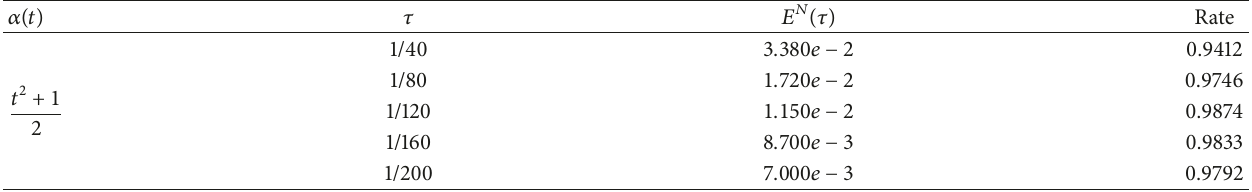
Table 4: Maximum errors and convergence rates for Example 1 at 𝑇 = 1 and 𝜎 2 = 𝜎 + 0.1 . 𝛼(𝑡)